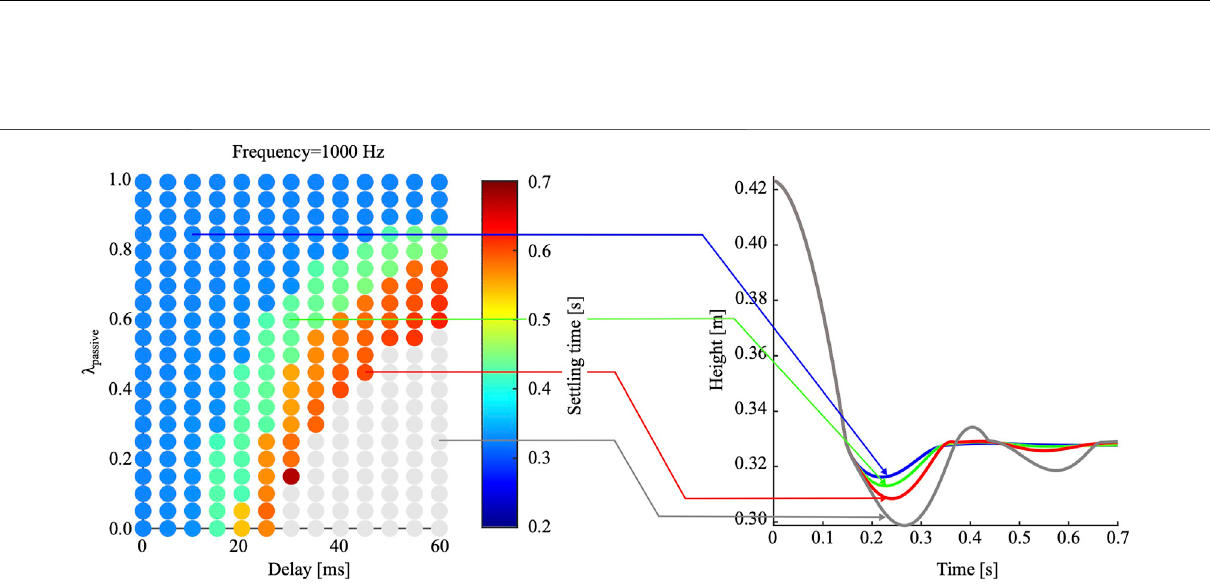
Frontiers in Robotics and AI |